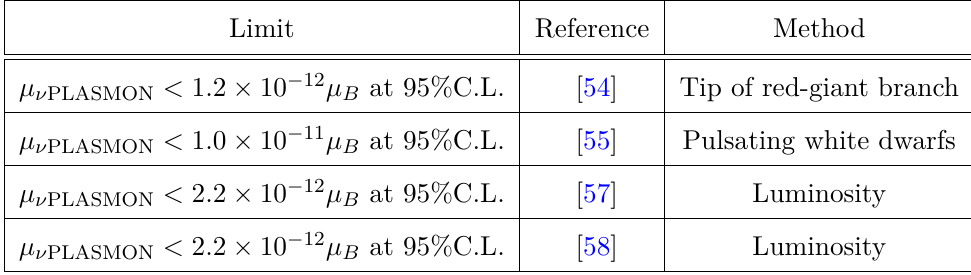
Table 5 . Limits on effective neutrino magnetic moments from plasmon decays in